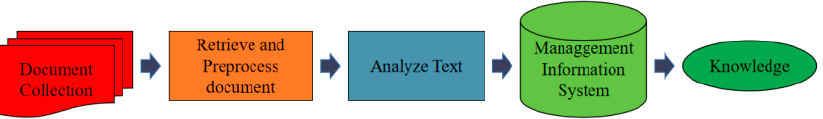
Figure 1. Text mining process .